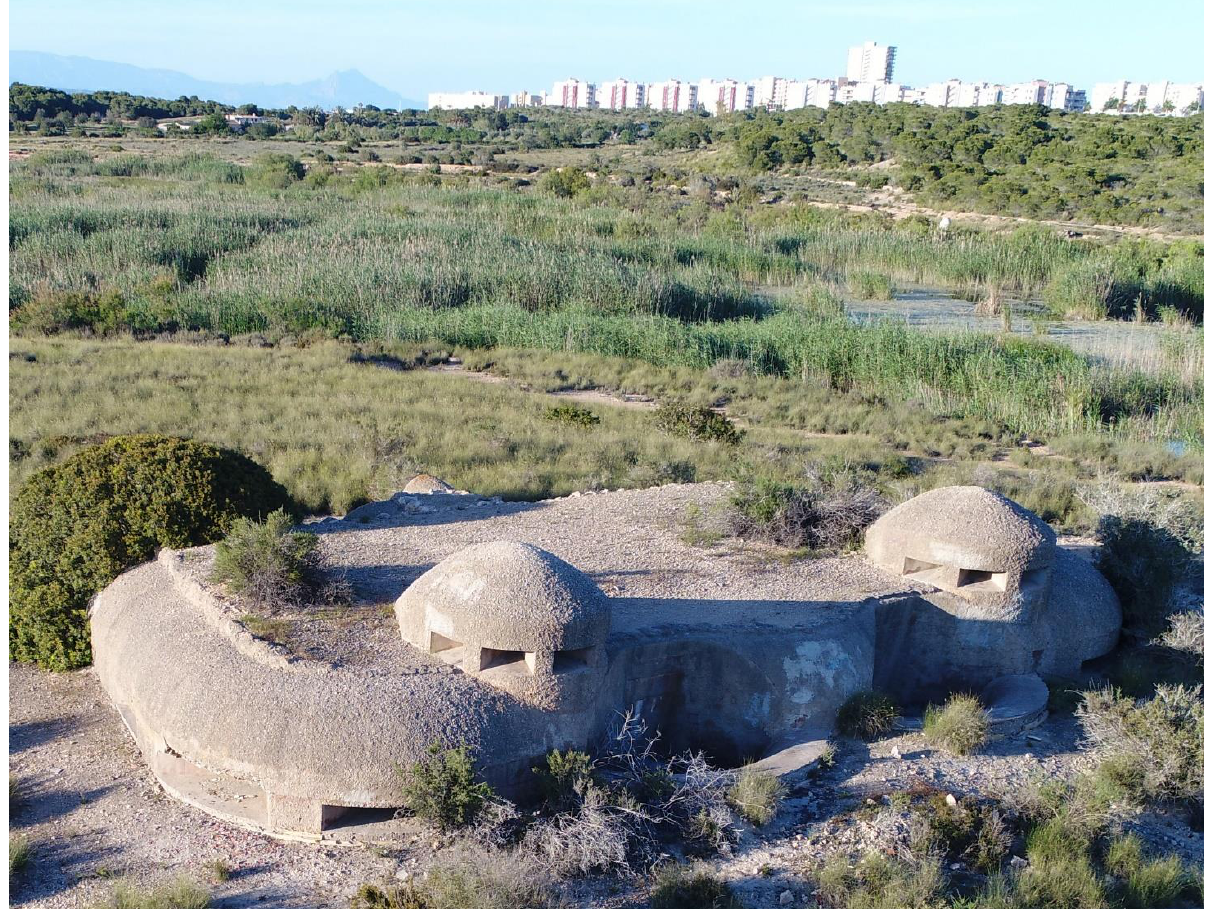
Figure 3. Current photography of the main bunker (CG-BK04.elc) taken from the drone; in the foreground the southern front with various defensive elements (loopholes, hatches and pits); behind are the hills of Arenals and Cabeçó, the tourist developments and, in the background, the Puig-Campana in the mountain ranges north of the province of Alicante (photo: